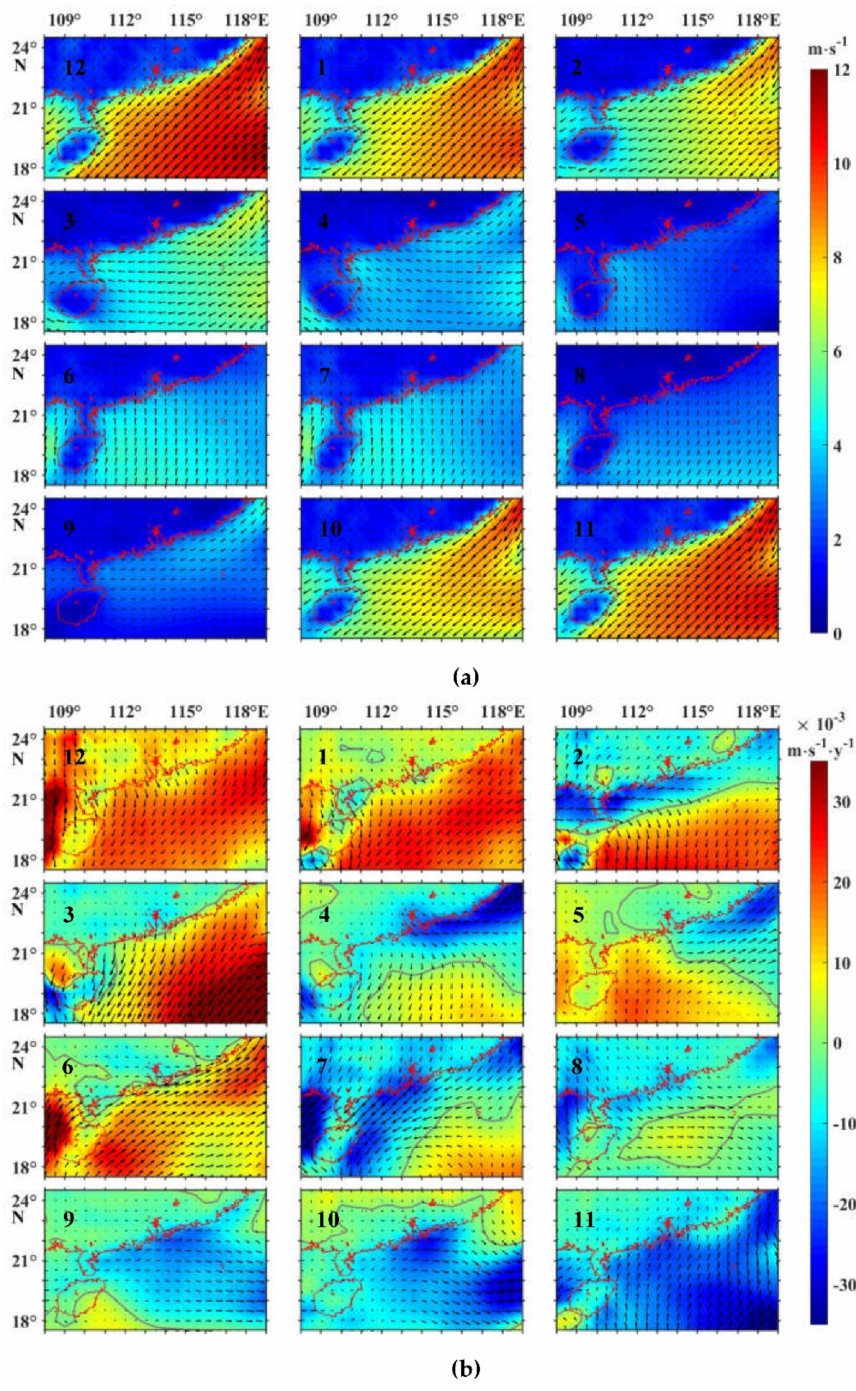
Figure 3. Spatial distribution of the monthly mean wind field ( a ) and its trend ( b ) in the northern South China Sea from 1979 to